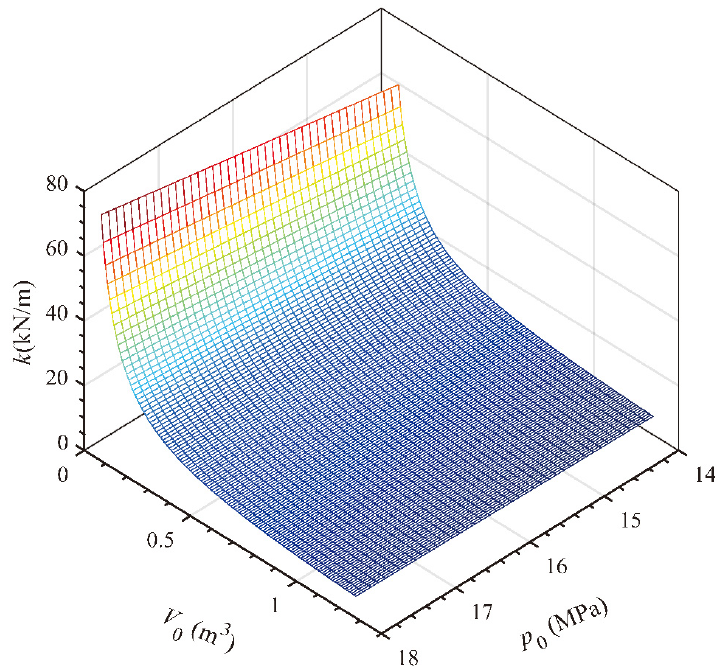
Figure 8. Effects of the high-pressure accumulator initial pressure and volume, p 0 and V 0 , on the stiffness coefficient, k .